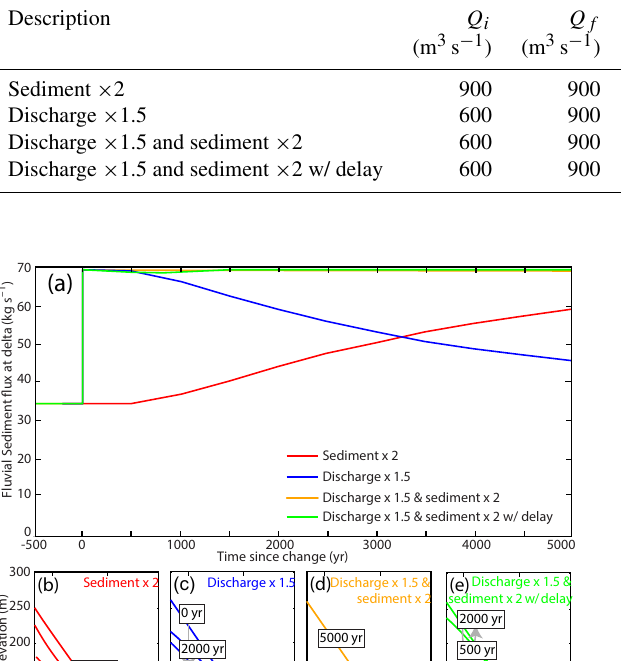
Table 3. Overview of the four river profile model experiments and their final equilibrium slope and bed level change. Q is the fluvial flood discharge, Q r is the upstream fluvial sediment supply, i is the initial antecedent fluvial environment, and f is the final fluvial environment. Description